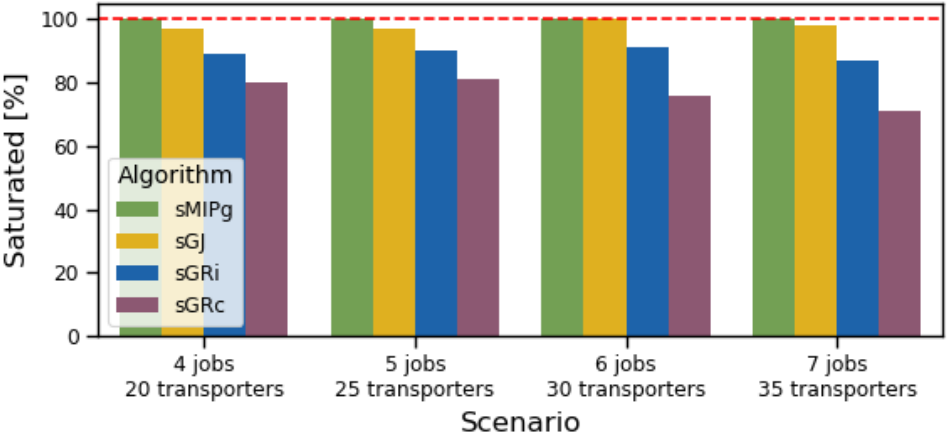
Figure 6. Share of the 100 instances where the respective algorithms do return a feasible, saturated